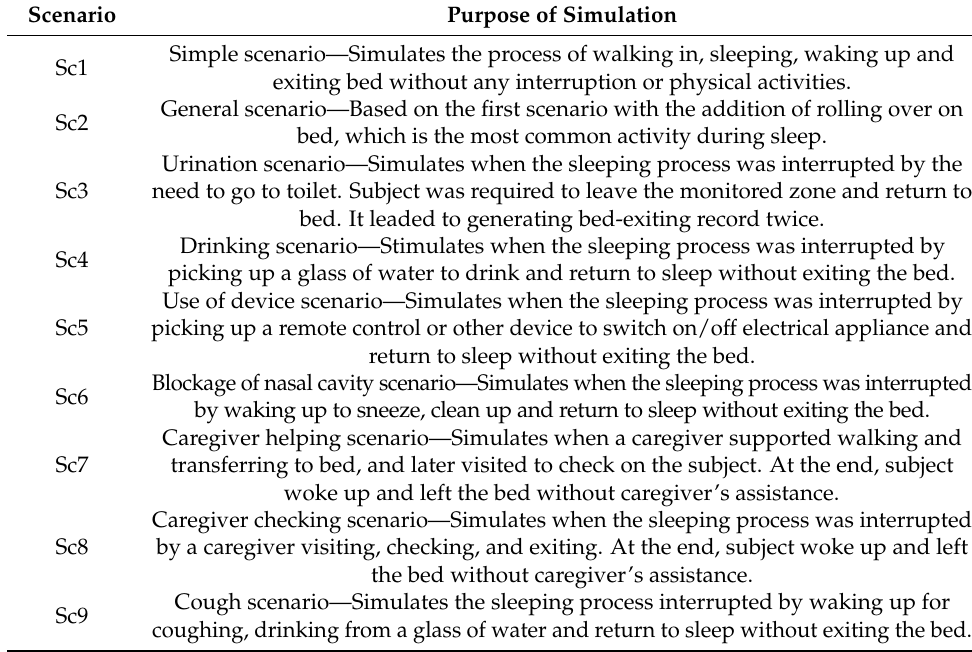
Table 2. Simulated bedtime activity